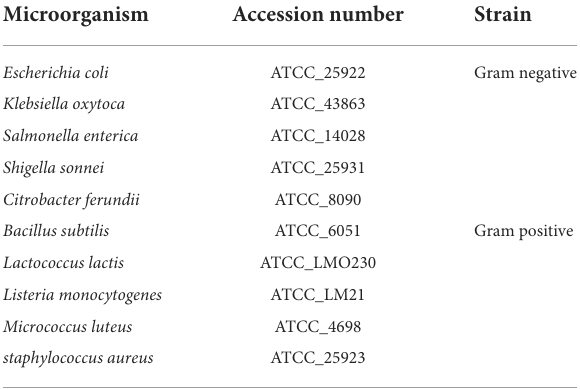
TABLE 1 Microbial profile of bacterial ingredients used in the antimicrobial analysis.